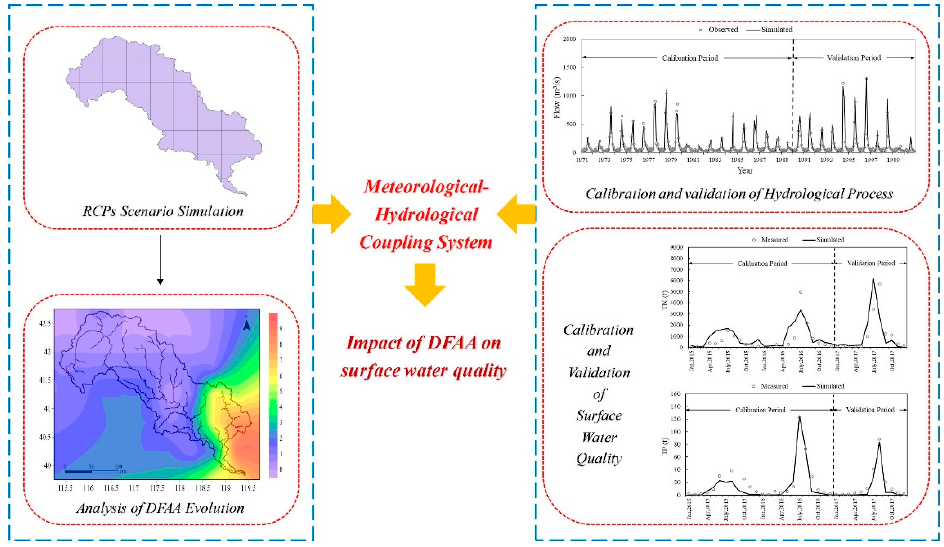
Figure 1. The framework of this study.